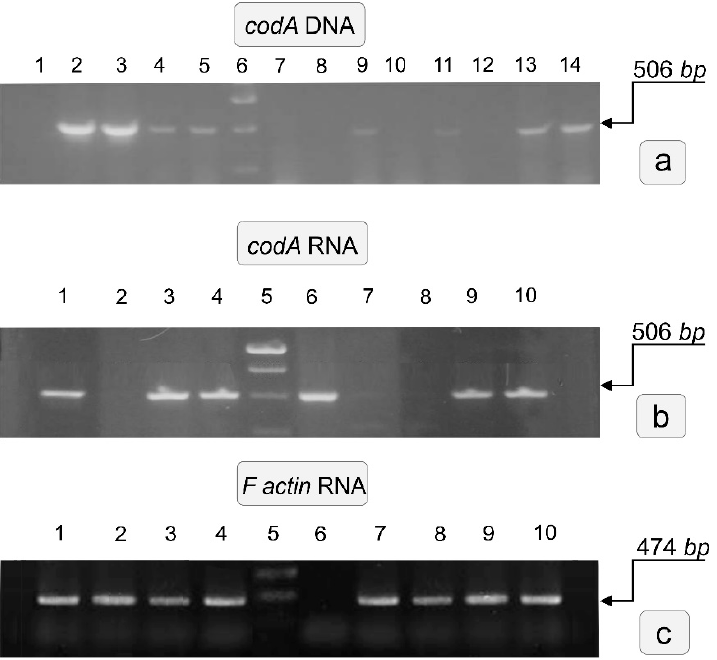
Figure 3. Detection of the codA gene integration in regenerated plants. ( a ) Genomic DNA PCR analysis of the codA from transgenic plants. Numbers: 1—H 2 O; 2—pBIcodA plasmid; 3—DNA 16